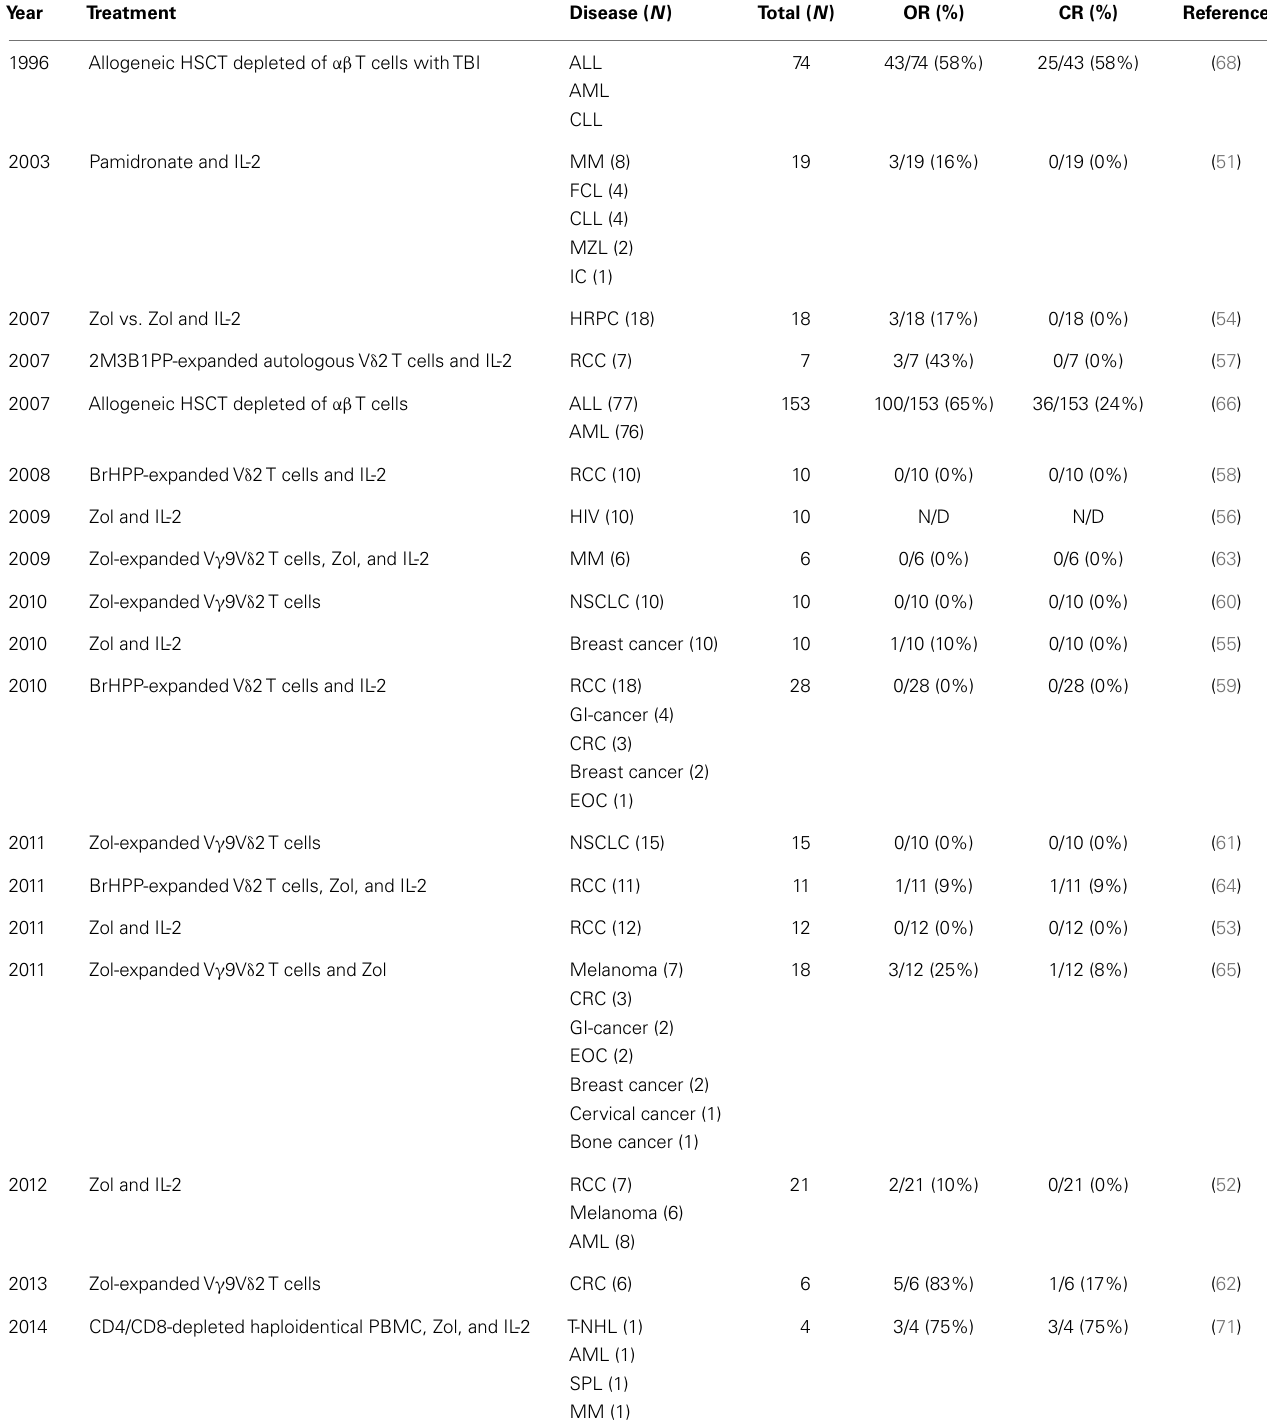
Table 1 | Clinical responses from γδ T cells